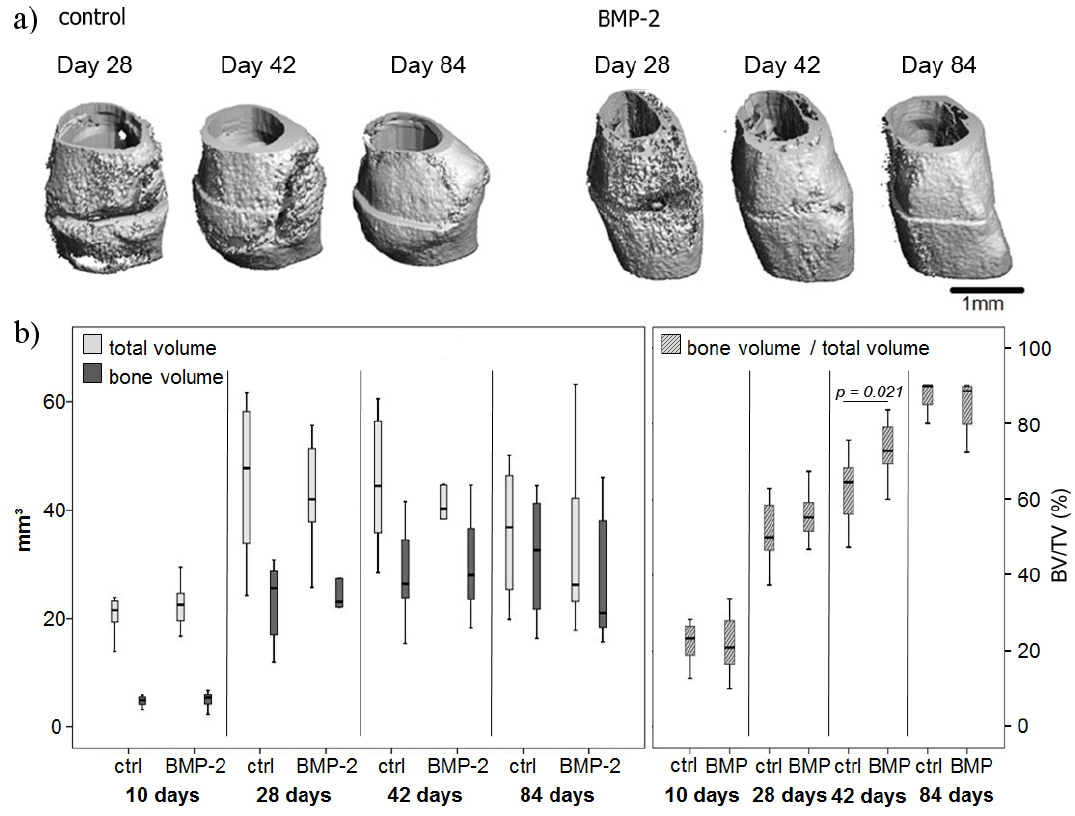
Figure 2. ( a ) µCT 3D reconstructions of selected tibiae of the control and the BMP-2 group over the healing time points. The scans were performed with the Viva40 µCT (Scanco) with a voxel size of 25 µm. The cortical bone has been removed. Scale bar: 1 mm; ( b ) Results of the µCT analysis of the control (ctrl) and the BMP-2 treated groups. The first graph shows the bone volume and total volume (total callus volume, including bone volume), and the percentage amount of mineralized bone in the total callus region is depicted in the second graph. The bone volume/total volume (in %) was significantly increased at Day 42 in the BMP-2 group compared to the control